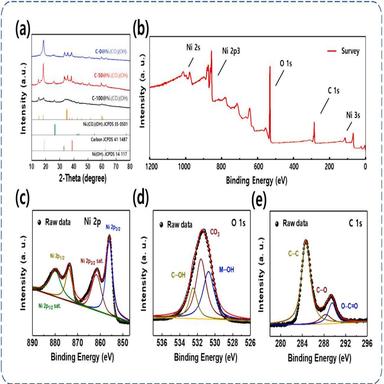
(a) XRD pattern of the Ni2(CO3)(OH)2 and core-shell carbon@Ni2(CO3)(OH)2 compounds; XPS spectrum of the optimized C-50@Ni2(CO3)(OH)2 compound: (b) XPS energy survey; (c) Ni 2p; (d) O 1s; (e) C 1s.